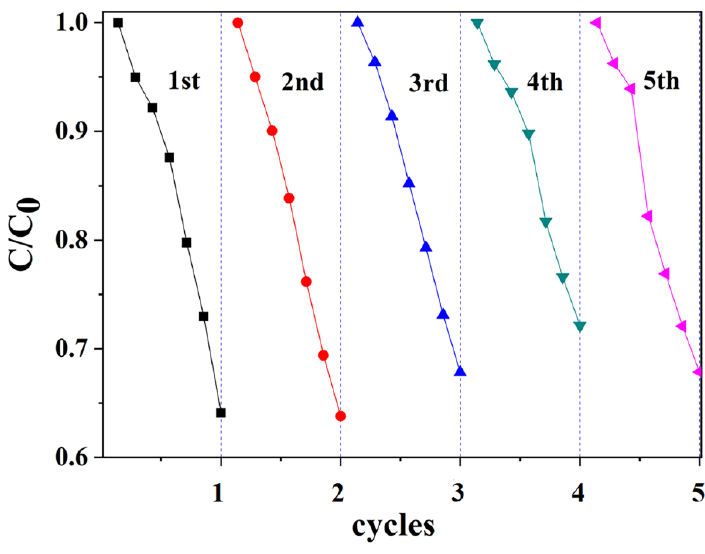
Figure 9. Cycling degradation experiment of 15% P-SSCN for 5 cycles.